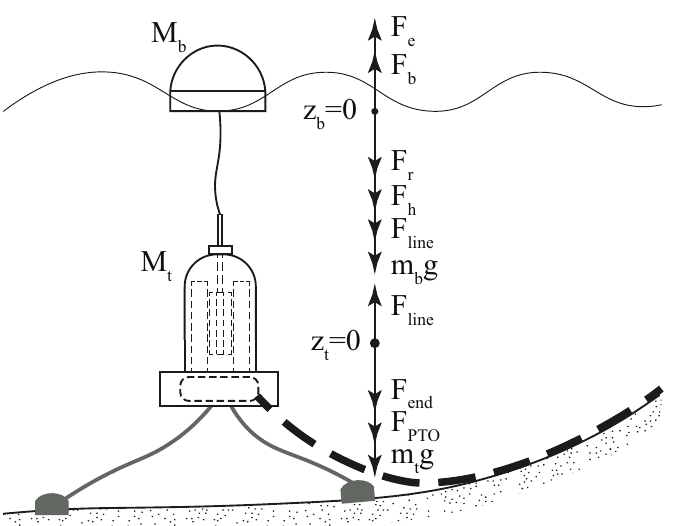
Figure 3. Characteristics of waves. Figure modified to add nomenclature for the vertical reference motion of the buoy and the